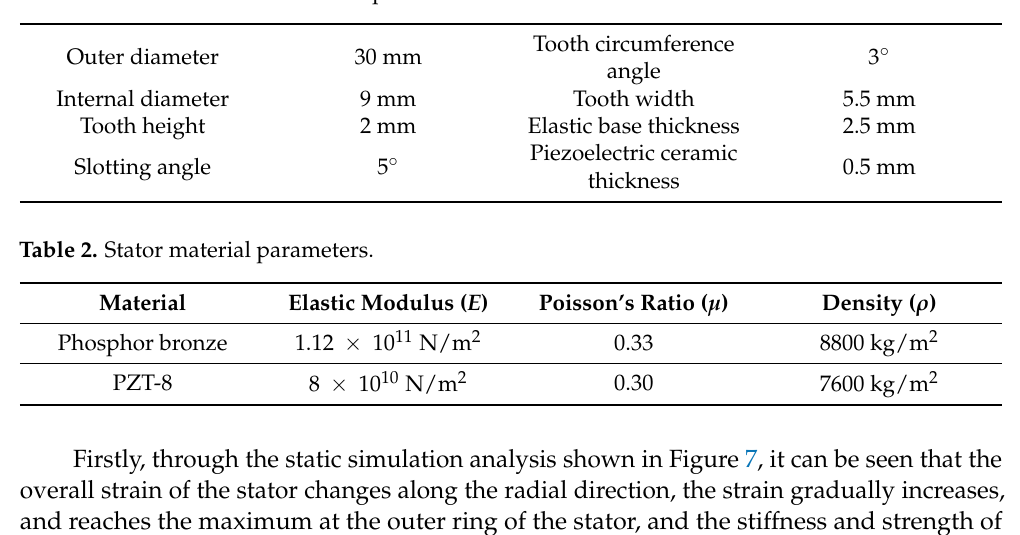
Figure 8. Schematic diagram of pre-pressure application.